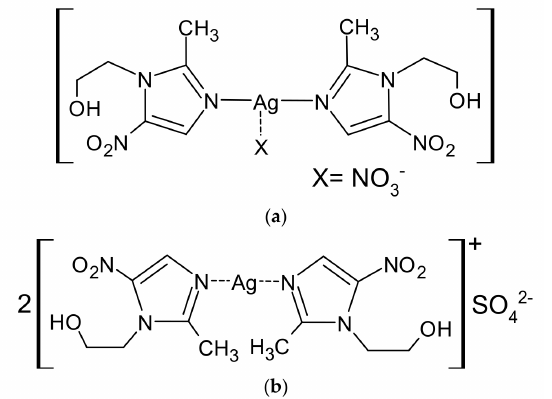
Figure 2. Complexes: I: metronidazole with silver(I) nitrate ( a ) and II: metronidazole with silver(I) sulfate ( b ).